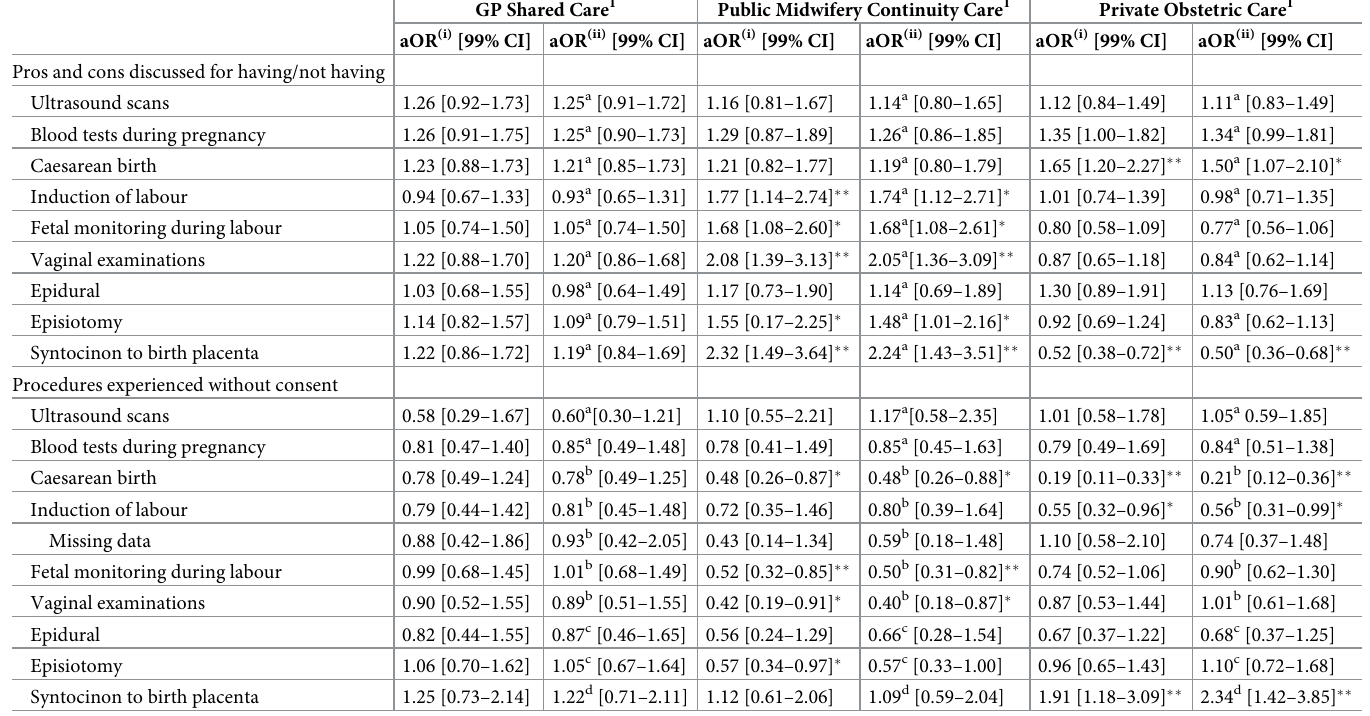
Table 5. Adjusted odds ratios for information provision and decision-making by maternity model of care, adjusting for (i) sociodemographic characteristics, repro- ductive history, and (ii) with additional adjustment for relevant clinical